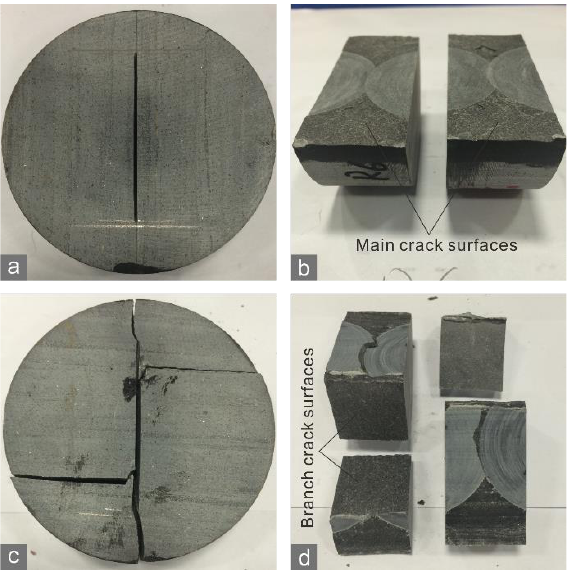
Figure 6. Crack morphologies of the shale CCNBD specimens with ( a , b ) horizontal and ( c , d ) vertical bedding orientations.